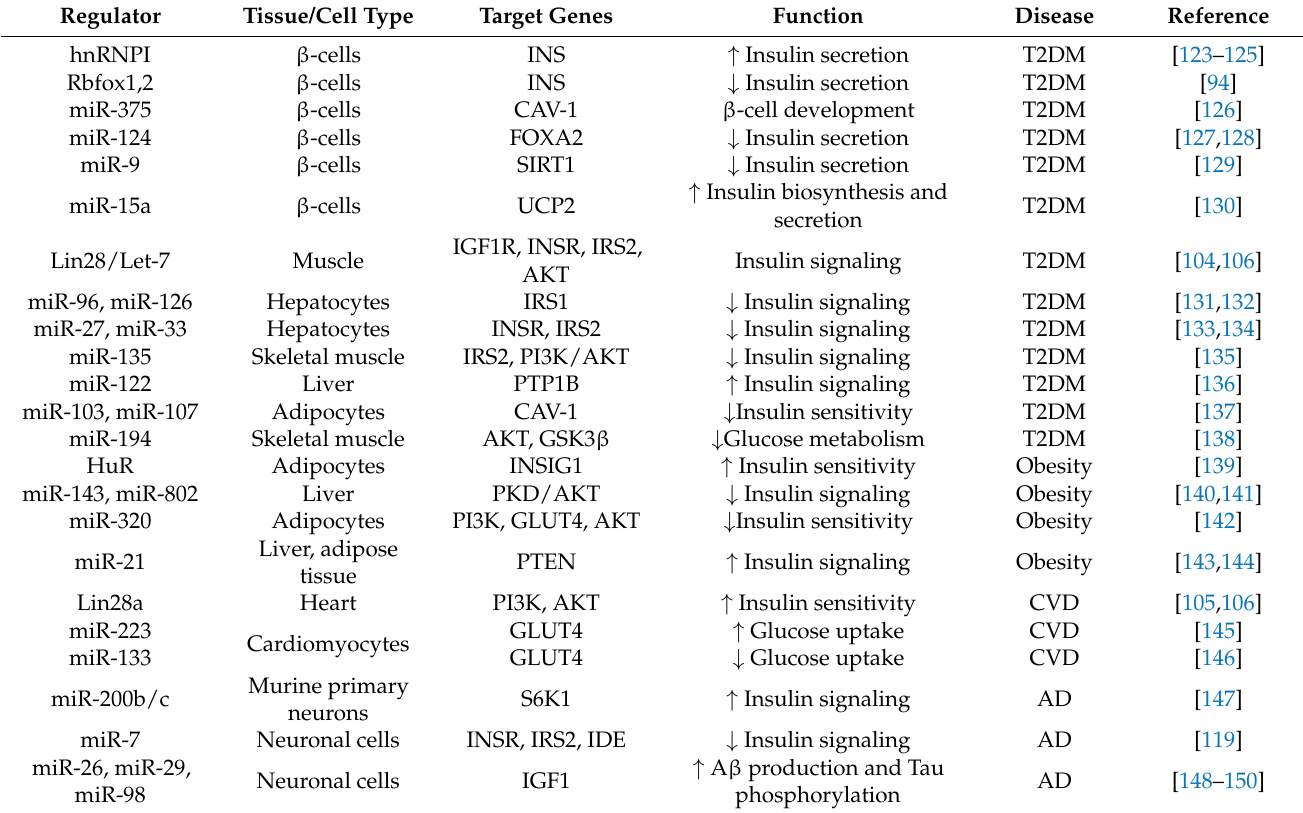
Table 2. miRNAs and RBPs involved in insulin signaling